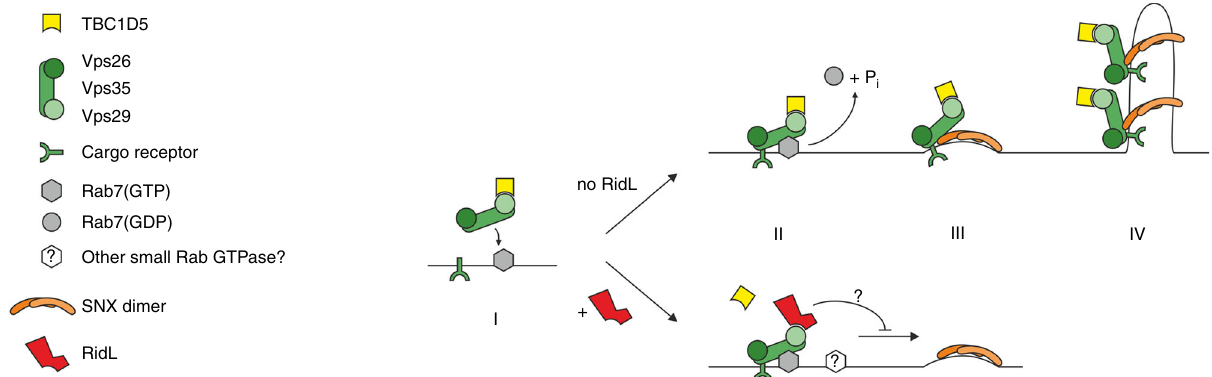
Fig. 8 Model of RidL displacement of TBC1D5. RidL 9 – 258 binds to Vps29 and displaces TBC1D5 from the retromer. (I) Retromer (Vps29-Vps35-Vps26) and TBC1D5 are recruited to the membrane by activated GTP-bound Rab7; cargo is recruited by the retromer. (II) In absence of RidL TBC1D5 leads to GTP hydrolysis and release of Rab7, whereas in presence of RidL TBC1D5 is displaced from Vps29, and retrograde traf fi cking is blocked by an unknown mechanism. (III) Retromer interacts with membrane-deforming sorting nexin (SNX) dimers. (IV) Transport tubules are formed involving other factors not shown here for